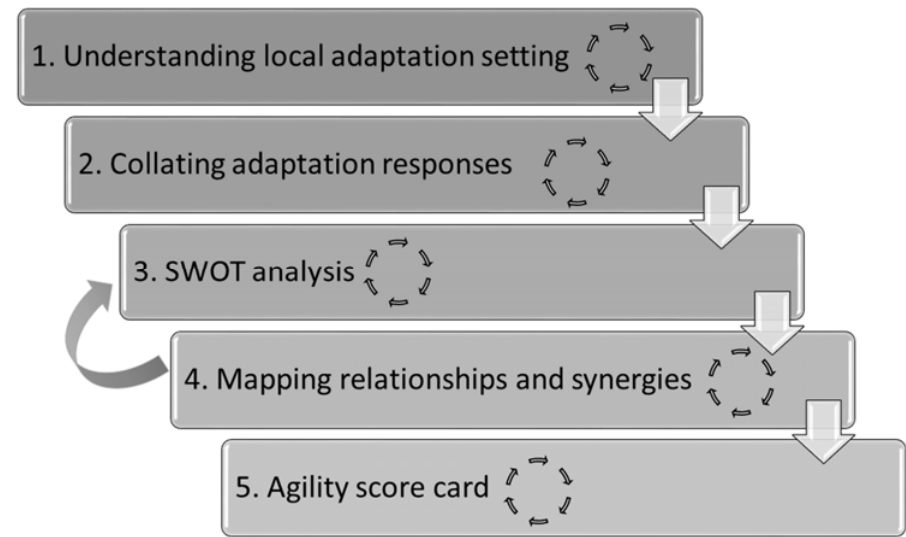
Figure 1. Scoping for using an agile urban adaptation process using a five step operational process.